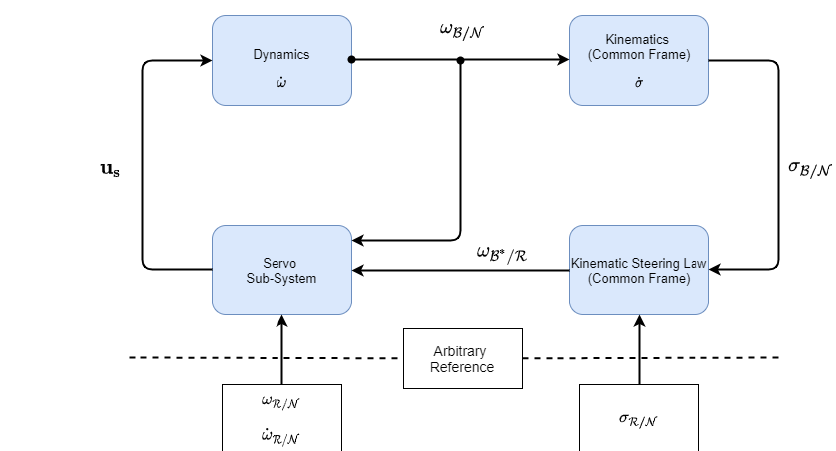
Figure 6. Control block proposed by [20]. The outer loop consists of the Kinematic Steering Law, while the inner loop consists of the servo